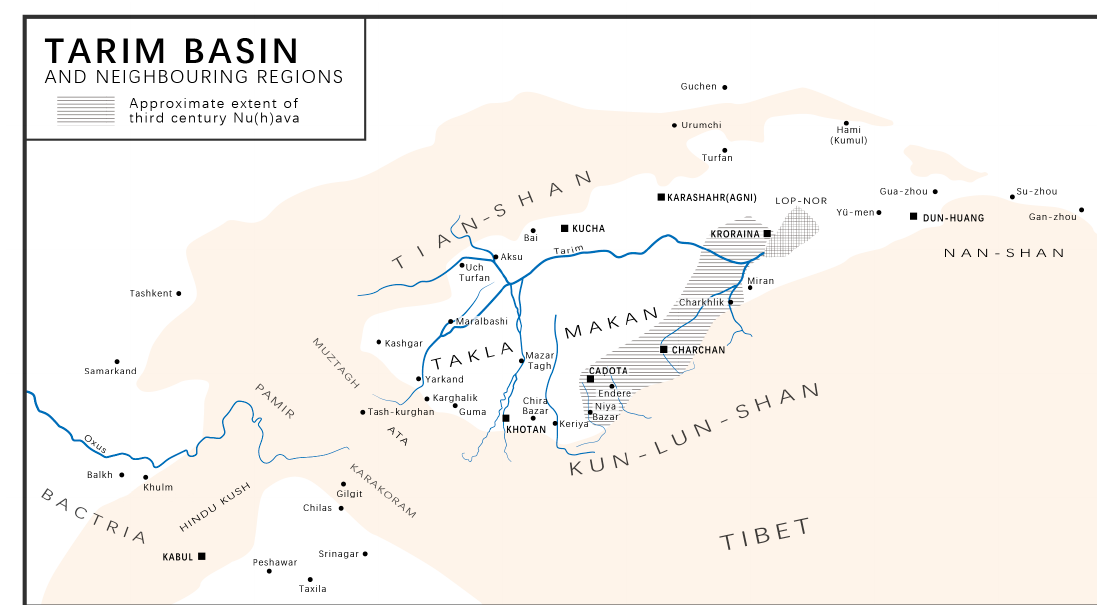
Figure 1 Tarim Basin and Neighbouring Regions (3rd cent. AD). Modified after Brough (1965) by Yang